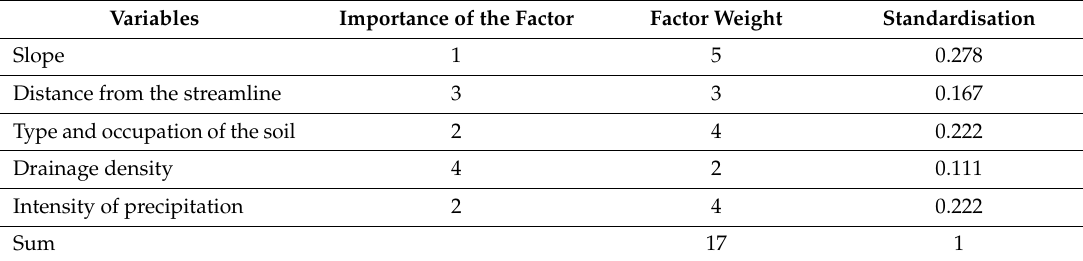
Table 6. Composite index for the evaluation of mass movements susceptibility in